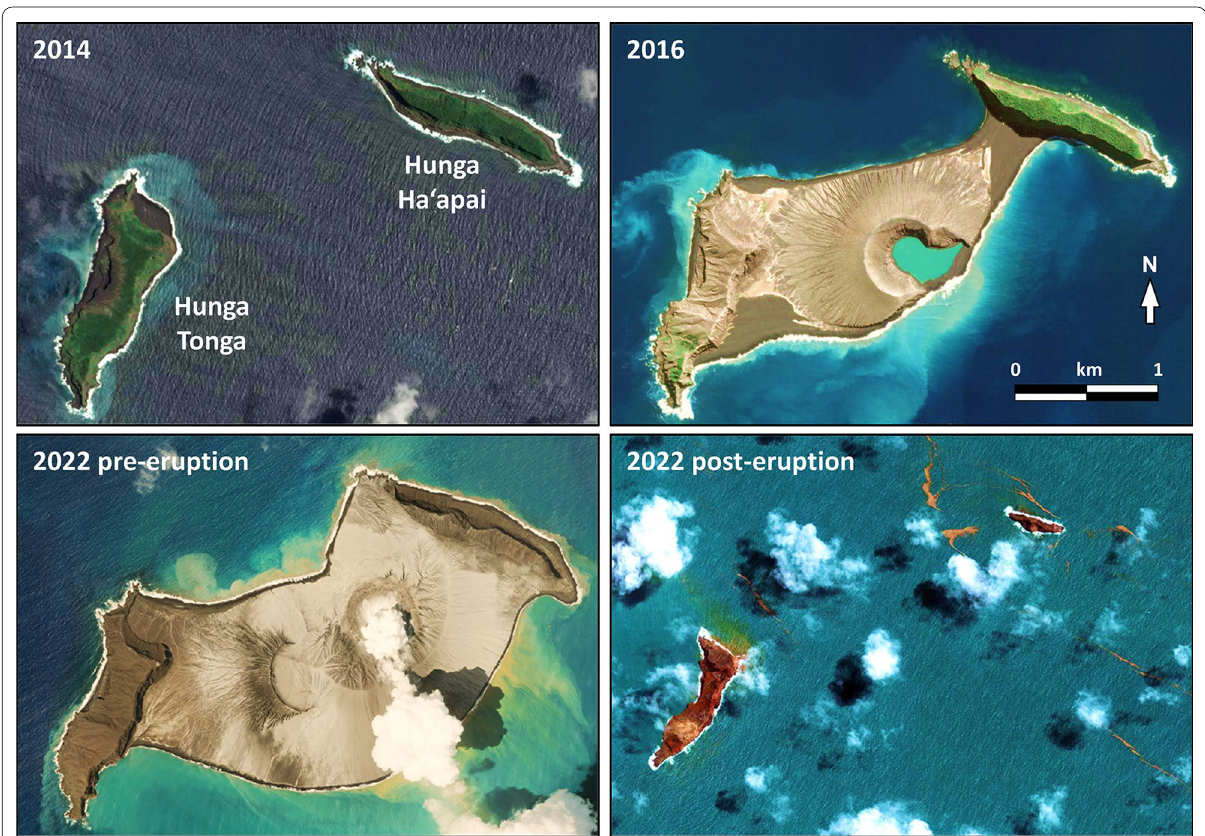
Fig. 2 Changes in the Hunga Tonga–Hunga Ha ʻ apai volcano over time. Note the subaerial growth during a constructional phase of volcanic activity from 2014 to early 2022. Two separate islands existed on the rim of the caldera in 2014. These were connected by an eruption in 2014–2015, but subsequently disconnected and almost completely destroyed by the explosive eruption on 15 January 2022. The image in the bottom right is from 18 January 2022, three days after the most recent eruption. Credits for satellite images: CNES/Airbus and Maxar